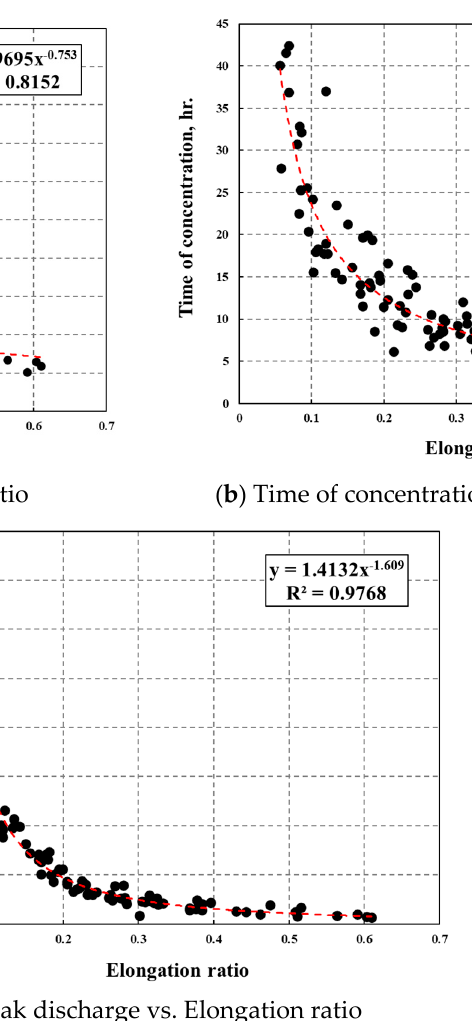
( c ) Peak discharge and elongation